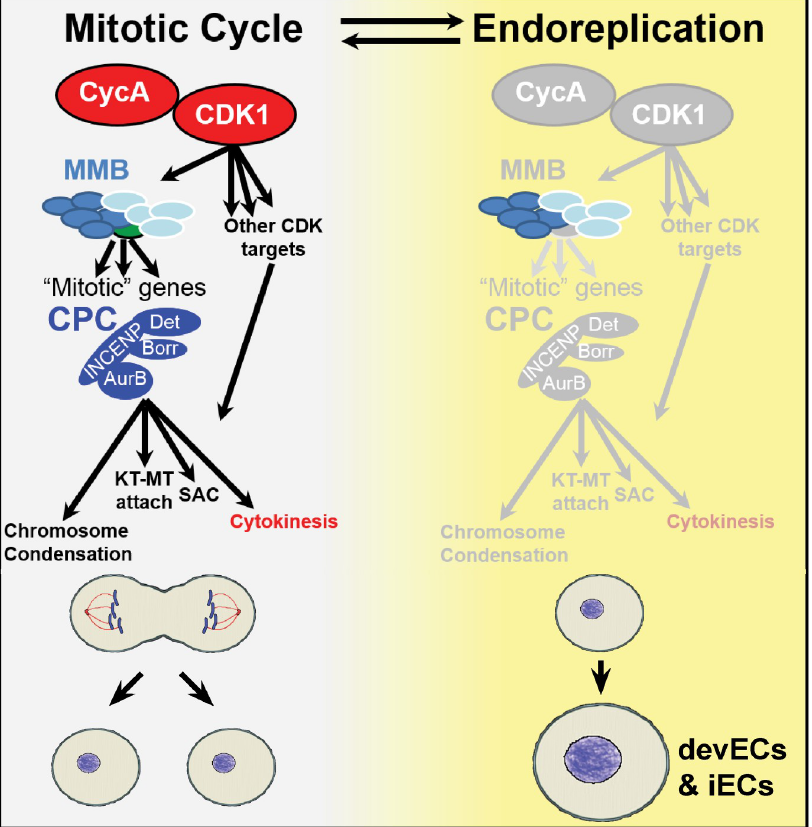
Fig 7. Model: The CycA—Myb—AurB network regulates the choice between cell cycle programs. Depicted are two alternative cell cycle programs, the mitotic cycle (left), and endoreplication cycle (right, yellow). During mitotic cycles, CycA / CDK1 activates the Myb-MuvB (MMB) to induce transcription of multiple genes with mitotic functions (“mitotic” genes). Among these are the subunits of the chromosome passenger complex (CPC), which phosphorylates multiple targets to regulate chromosome condensation, kinetochore-microtubule (KT-MT) attachment, the spindle assembly checkpoint (SAC), and cytokinesis. Our findings suggest that CycA / CDK1, MMB, and the CPC are key nodes of this mitotic network whose repression promotes a transition to endoreplication in both iECs and devECs. See text for further details.